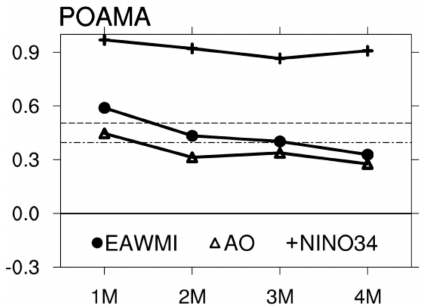
Figure 10. Correlation coefficients between the observed indices and the indices derived from POAMA for different lead months. Values are shown for EAWM, AO and Nino 3.4. Two dashed lines denote the 95% and 99% confidence level, respectively. Here, the hindcast outputs were examined with different lead times from 1 to 4 months targeting for boreal winter (DJF), which were initialized near the first day of each month from Nov to